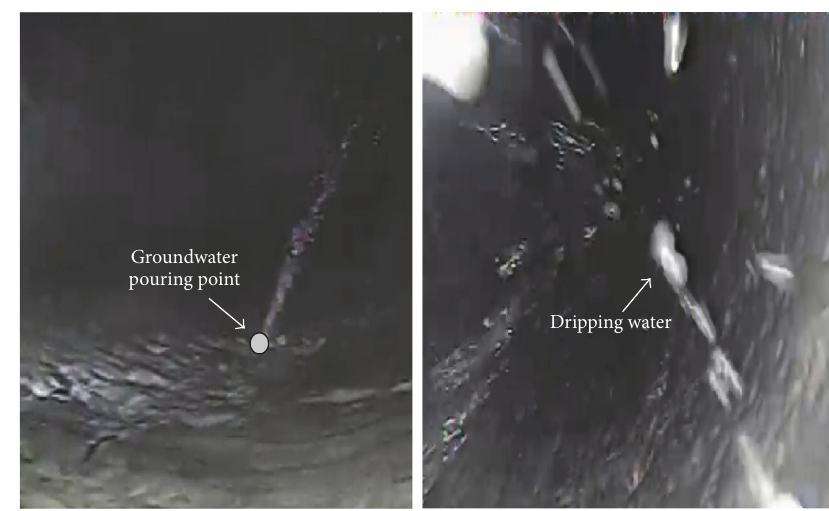
Figure 1: Abandoned gob distribution within the Yongan mine range.